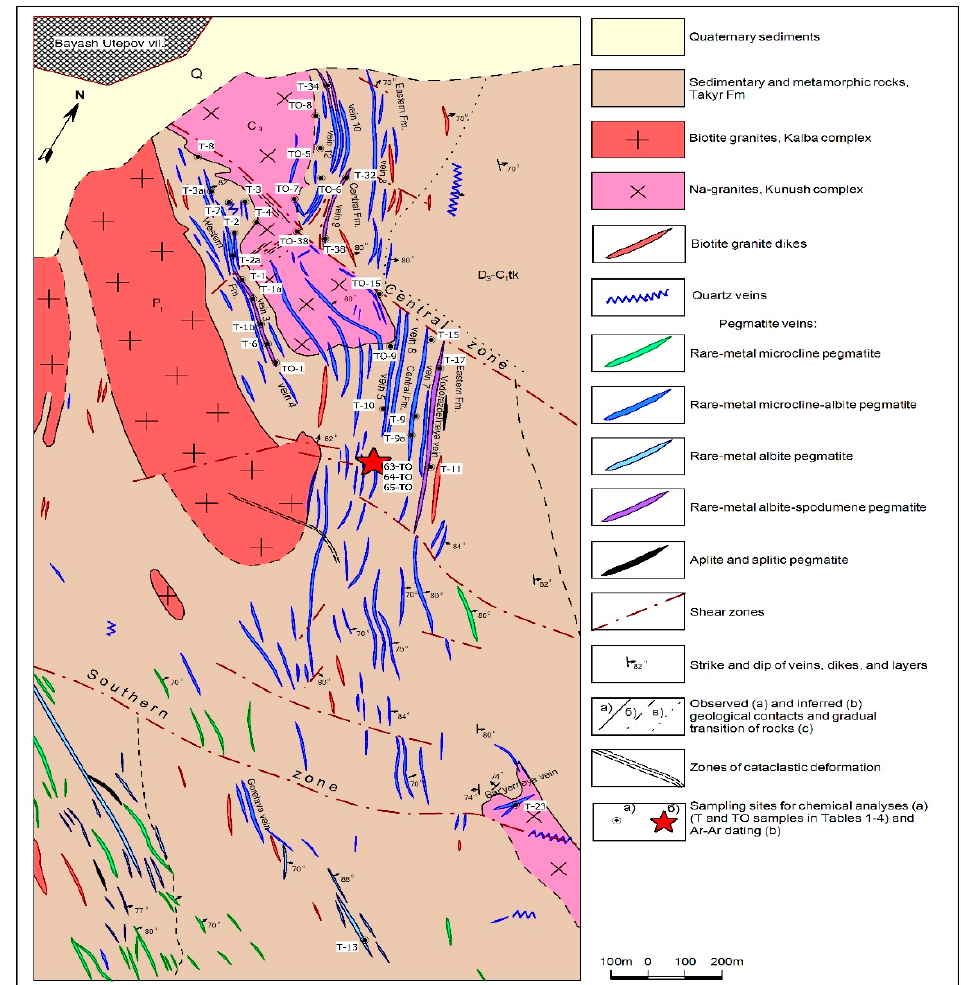
Figure 2. Local geology of the Tochka deposit, from Kashcheev et al.,